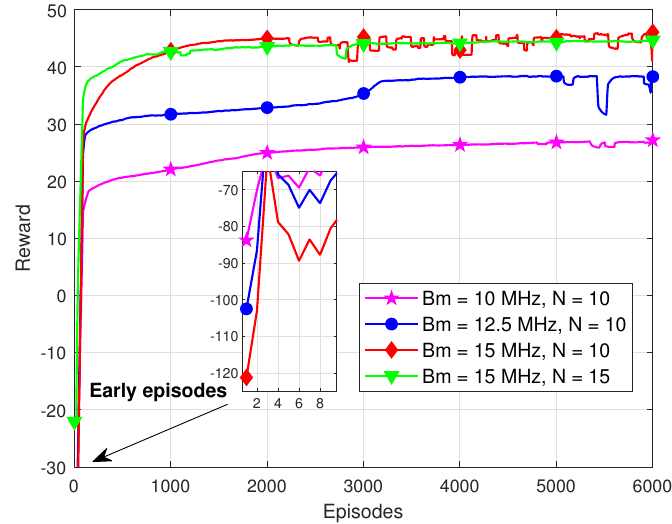
Figure 4. Performance for AL-SAC algorithm with different maximum available